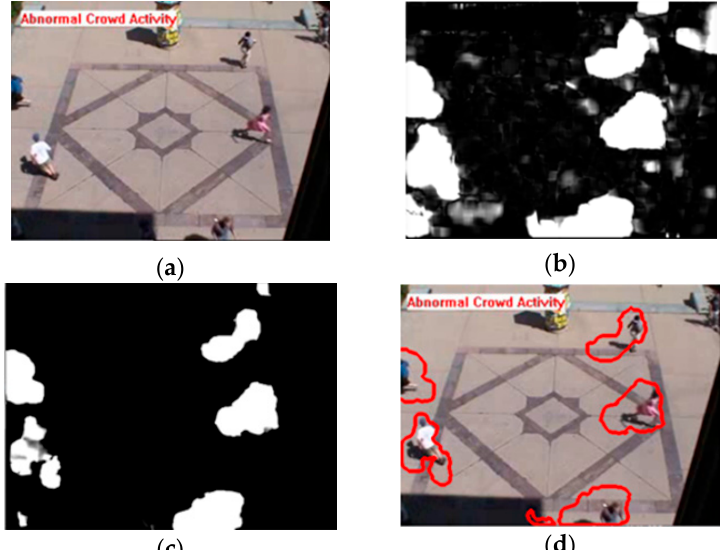
Figure 5. Example result of calculating R mag . ( a ) original frame; ( b ) F mag ; ( c ) R mag ; ( d ) result of the system.